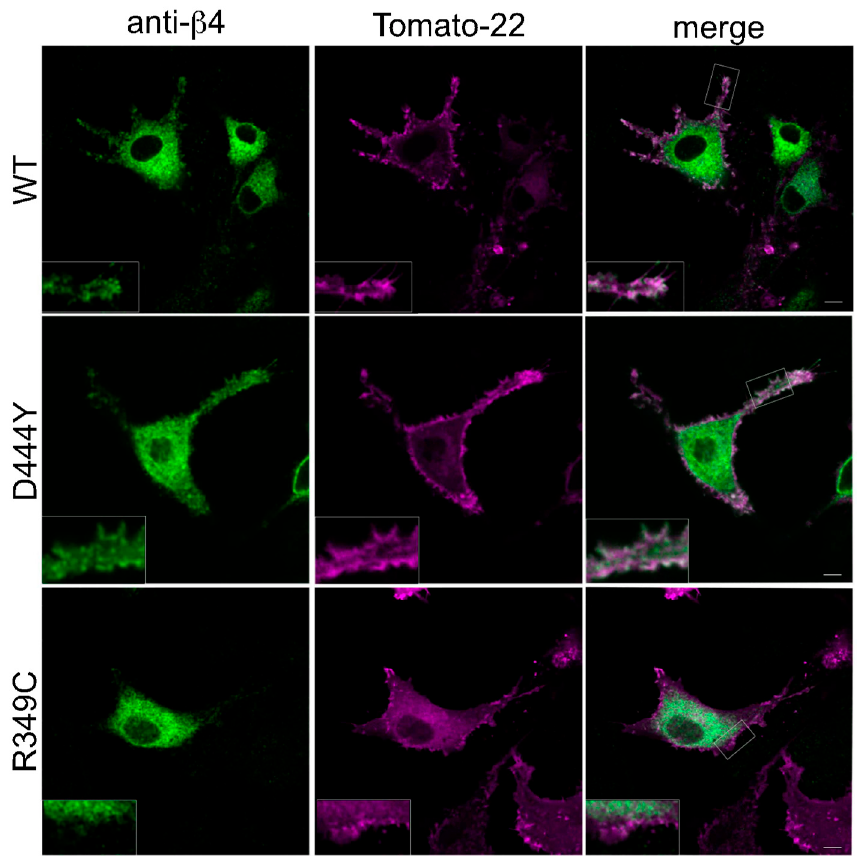
Figure 2. The presence of an accessory R349C- β 4 subunit in the pentamers interferes with the surface exposure of nAChRs. NRK cells cotransfected with a plasmid encoding the Tomato-22 protein that marks the plasma membrane plus α 3 β 4 nAChRs with a WT- β 4, D444Y- β 4 or R349C- β 4 subunit in the fifth position. After being incubated at 32 ◦ C for 48 h, the cells were fixed and stained with anti- β 4 antibody. The α 3 β 4 nAChRs with a WT- β 4 or D444Y- β 4 subunit in the fifth position reached the plasma membrane and partially colocalised with Tomato-22, whereas the presence of the R349C- β 4 subunit interfered with transport from the ER membrane, and the α 3 β 4 nAChRs were mainly retained in the ER. Representative confocal images with enlarged insets (2.5 × ). Scale bar: 10 µ m.